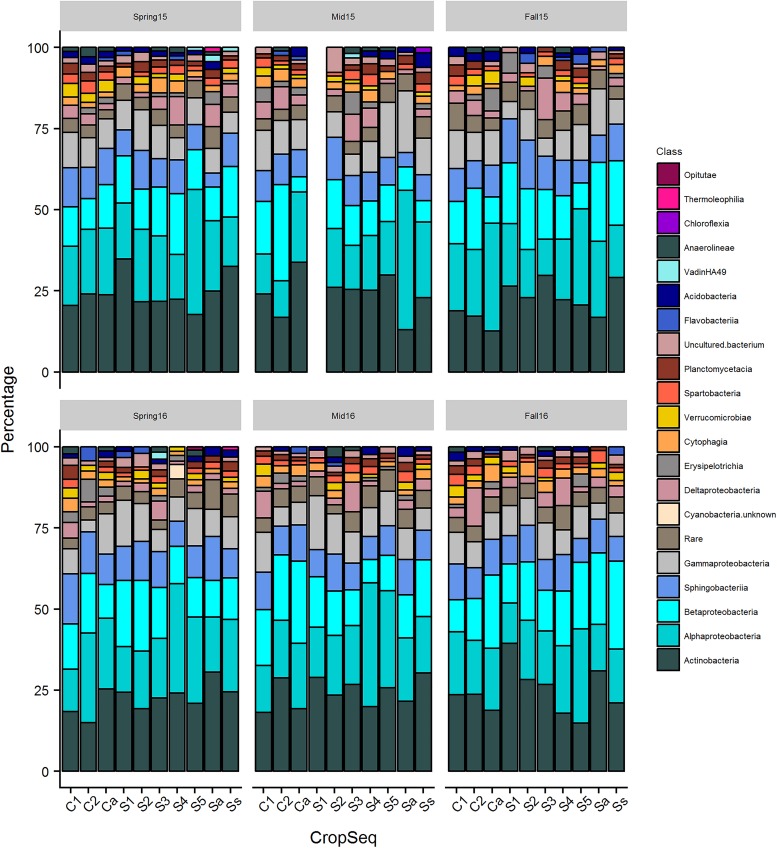
The distribution of bacterial classes containing at least 2% of total OTUs across crop sequences for each season. Percentage of OTUs from each class out of the total from the cyst community is shown on y-axis and taxa with higher percentage of OTUs are shown toward bottom of each column.